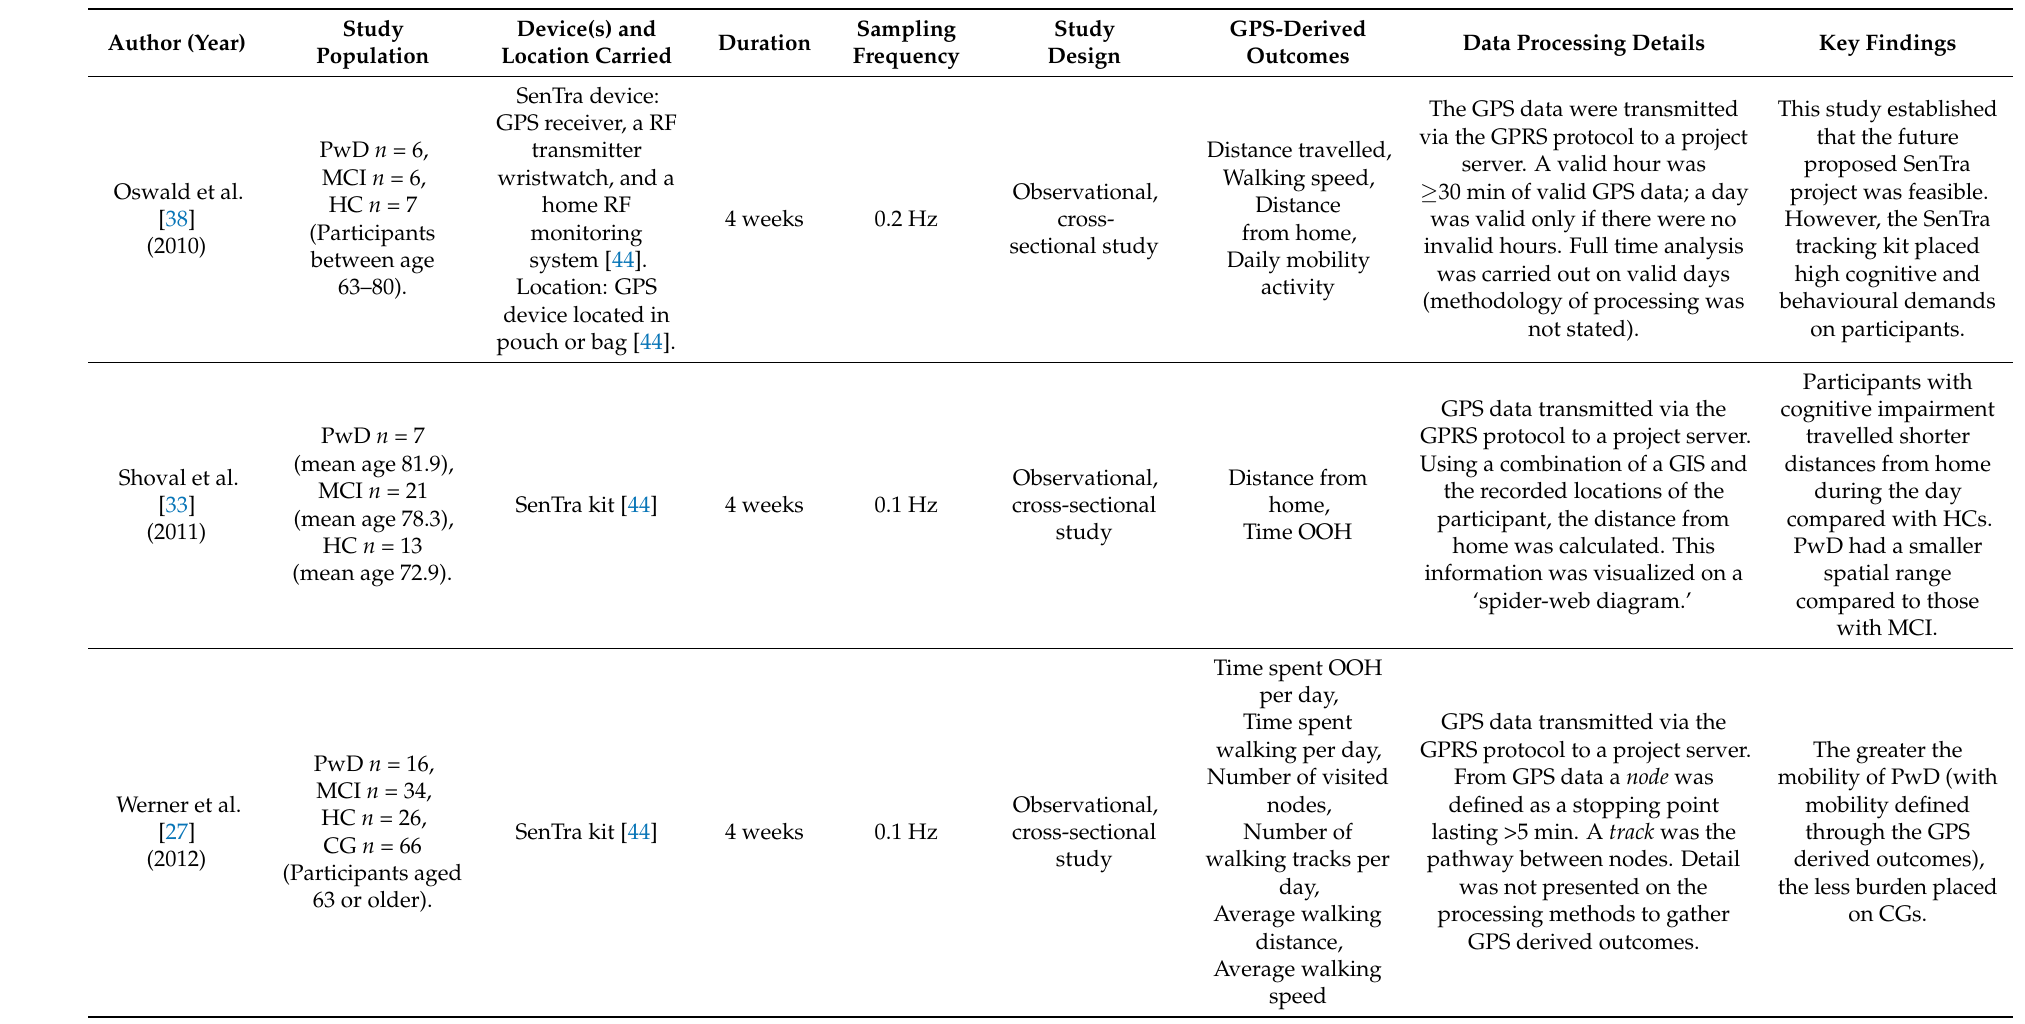
Table 1. Summary of identified papers where GPS has been used in patients with dementia disorders. Participant age is presented as mean (SD) where